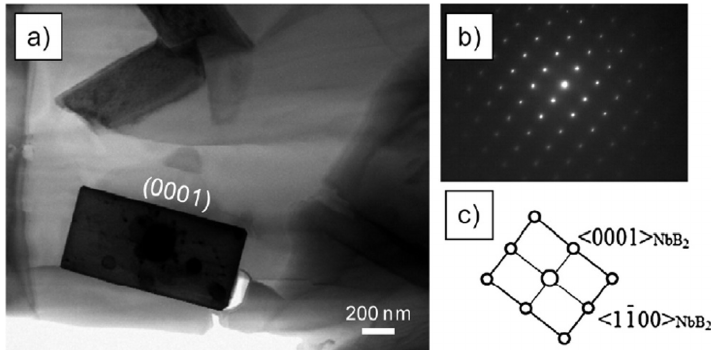
Figure 4. The representative TEM analyses result from the heterogeneous nuclei present in Al-Nb-B master alloy: (a) bright field micrograph showing the hexagonal plate-like morphology of NbB